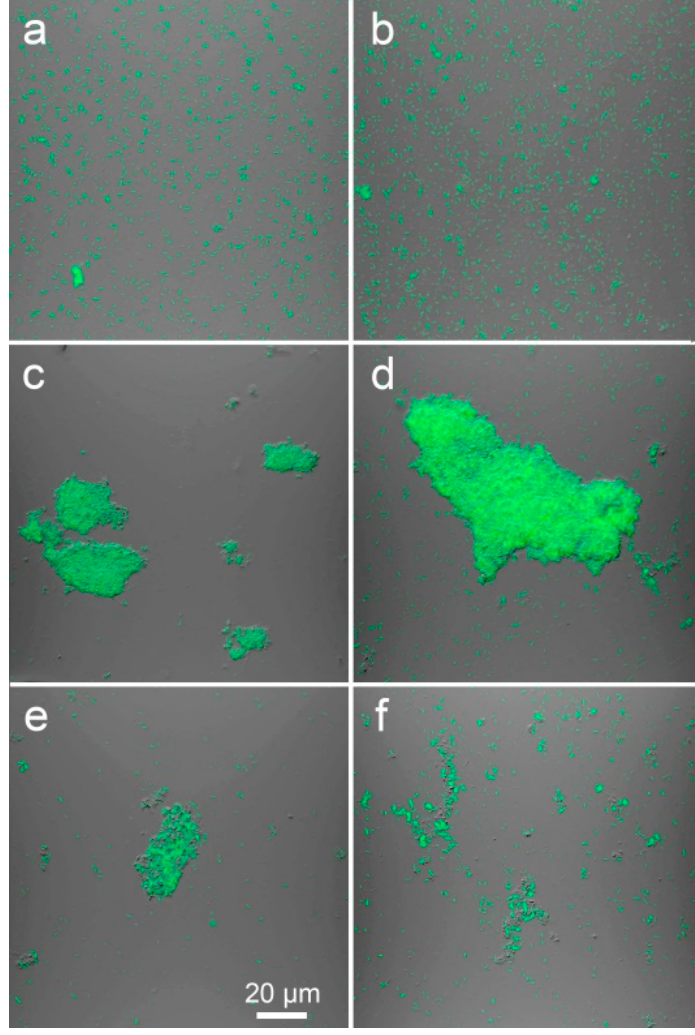
Figure 2. Confocal laser scanning images of Pseudomonas fluorescens SPB2137gfp batch culture in the absence of Al ( a , b ) and in the presence of 80 ( c , d ) or 160 ( e , f ) µM AlCl 3 . The bacteria are colored green. Images are single optical sections ( a , c , e ) and 10 merged optical sections ( b , d , f ). Scale bar (20 µm) shown in e is the same for all images.